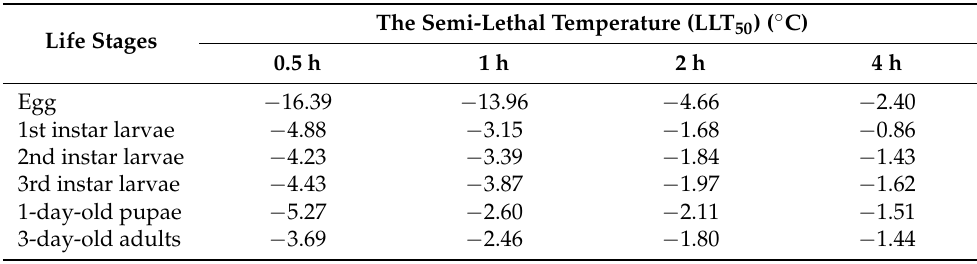
Figure 1. Influence of extreme low temperature and exposure time on the mortality rate of different developmental stages of Bactrocera tau . ( A ) Eggs, ( B ) 1st instar larvae, ( C ) 2nd instar larvae, ( D ) 3rd instar larvae, ( E ) 1-day-old pupae, and ( F ) 3-day-old adults. Bars represent mean ± SE values. Differ- ent letters denote significant differences among exposure times at the same treatment temperature (ANOVA, p < 0.05). Table 2. Predicted temperature required to achieve 50% mortality of different life stages of Bactrocera tau under different cold